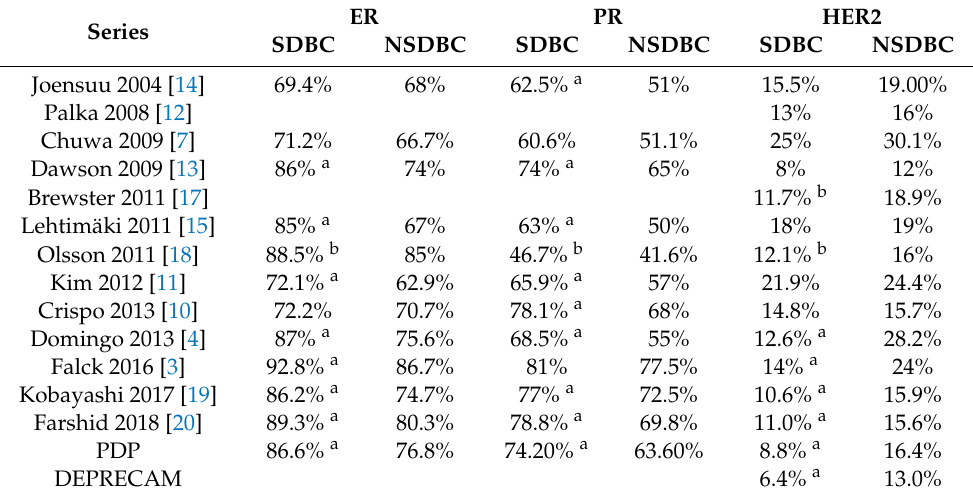
Table 8. Proportion of immunohistochemistry positive cases in the